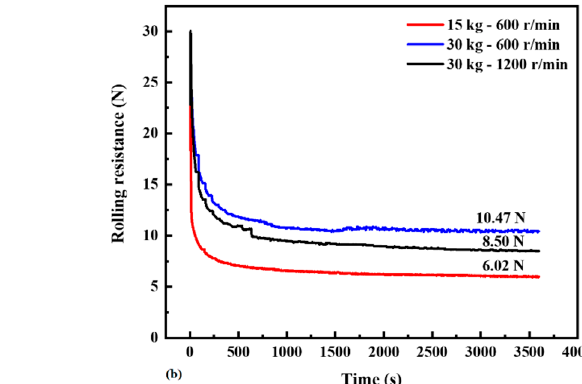
Figure 15. ( a ) Test data of the temperature vs. time curves at Point A shown in Figure 14b under different rotating speed and load, and ( b ) test data of the RR vs. time curves under different rotating speed and load.